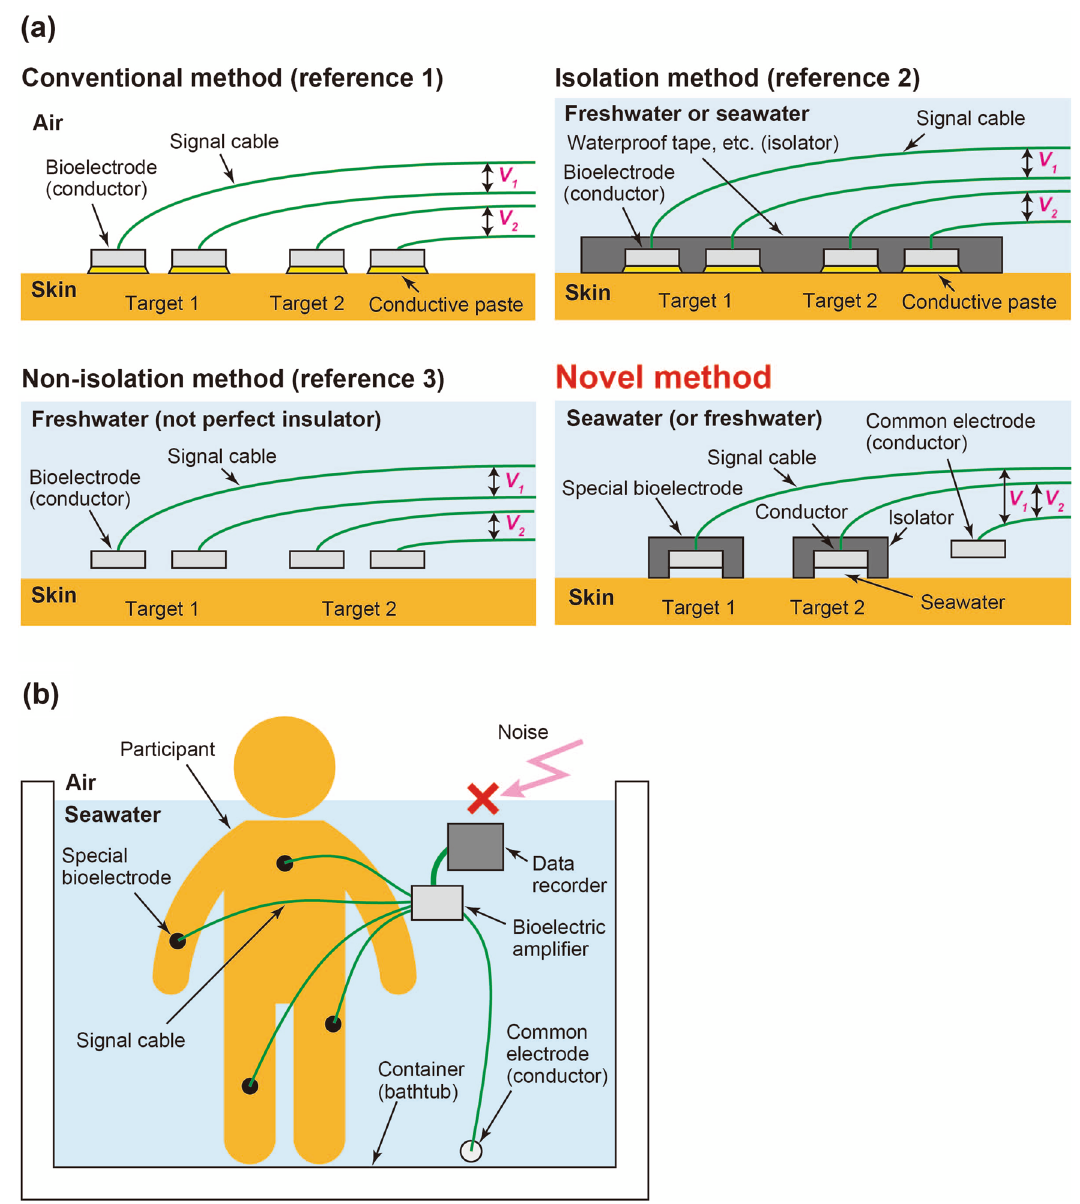
Figure 1. Novel method for noninvasive bioelectric measurement in seawater: ( a ) principle and ( b )